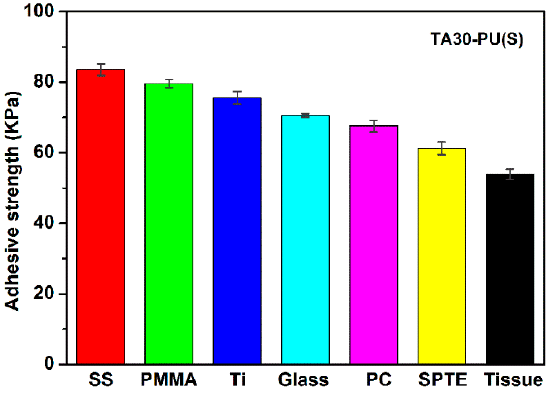
Figure 10. Adhesive strength of TA30-PU(S) hydrogels compared to stainless steel (SS), poly(methylmethacrylate) (PMMA), titanium (Ti), glass, polycarbonate (PC), tinplate (SPTE), and pork skin tissue.